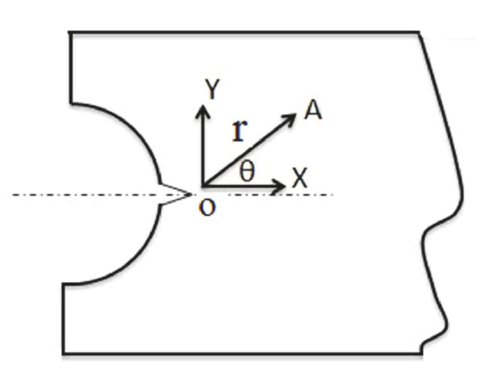
Figure 4: Schematicillustration of I-type crackin blasthole induced by